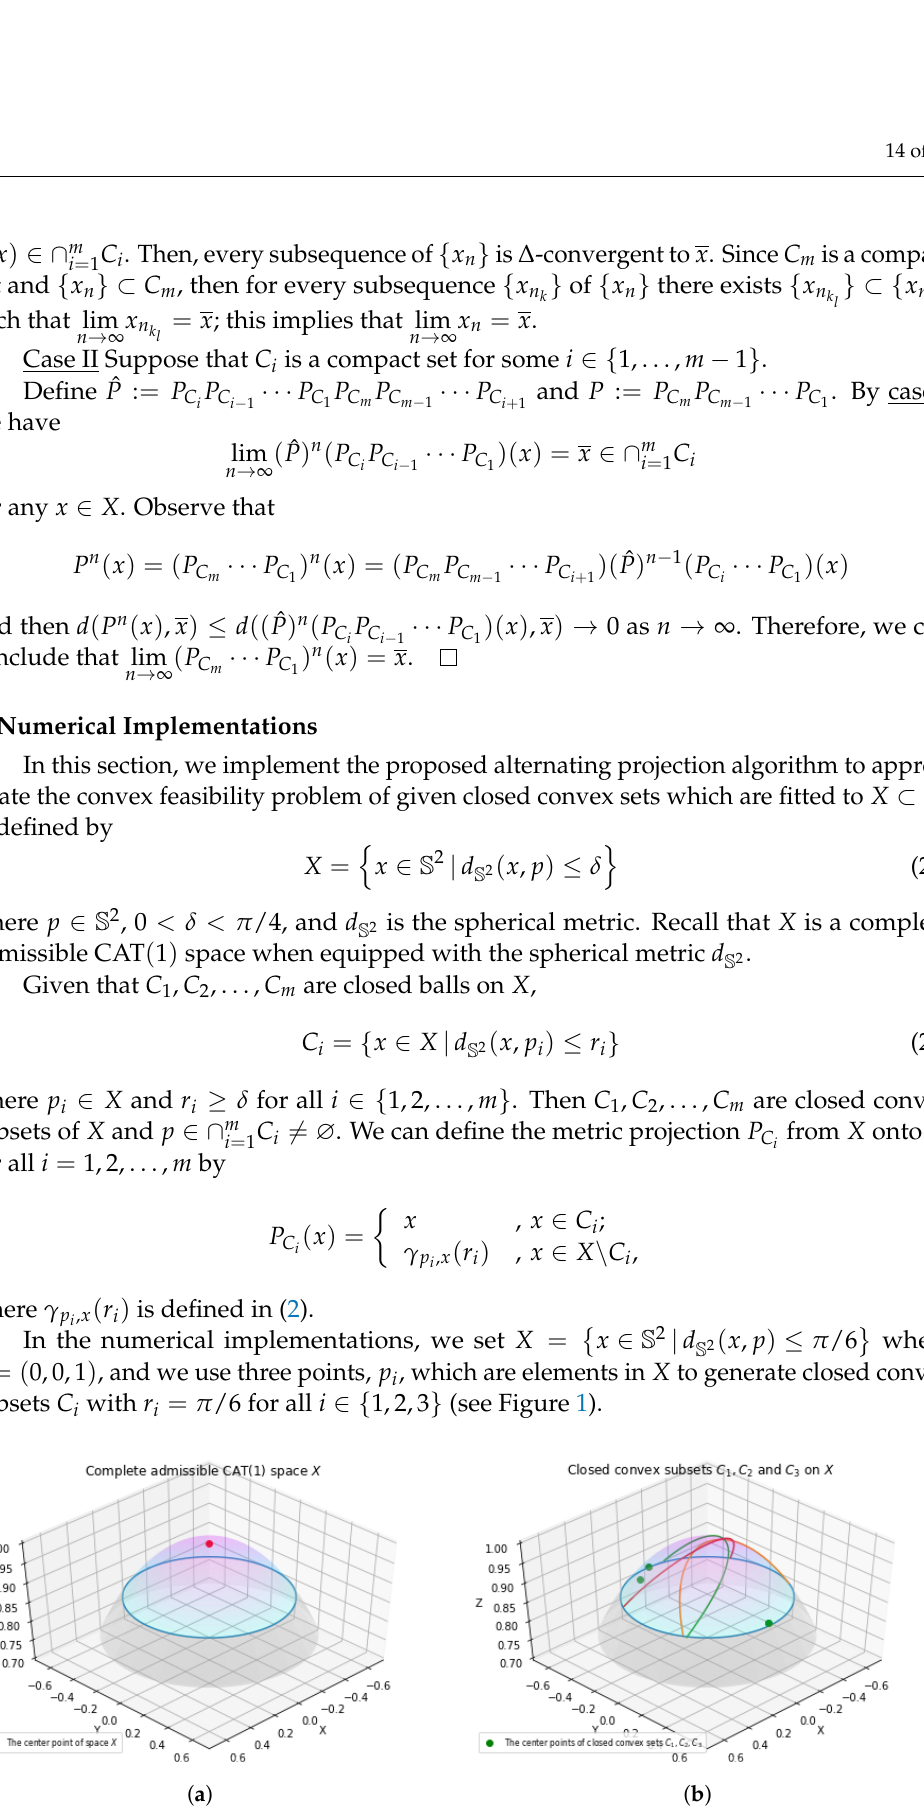
Figure 1. The complete admissible CAT ( 1 ) space X and closed convex subsets C 1 , C 2 , C 3 . ( a ) The complete admissible CAT ( 1 ) space. ( b ) Closed convex subsets C 1 , C 2 , C 3 on X